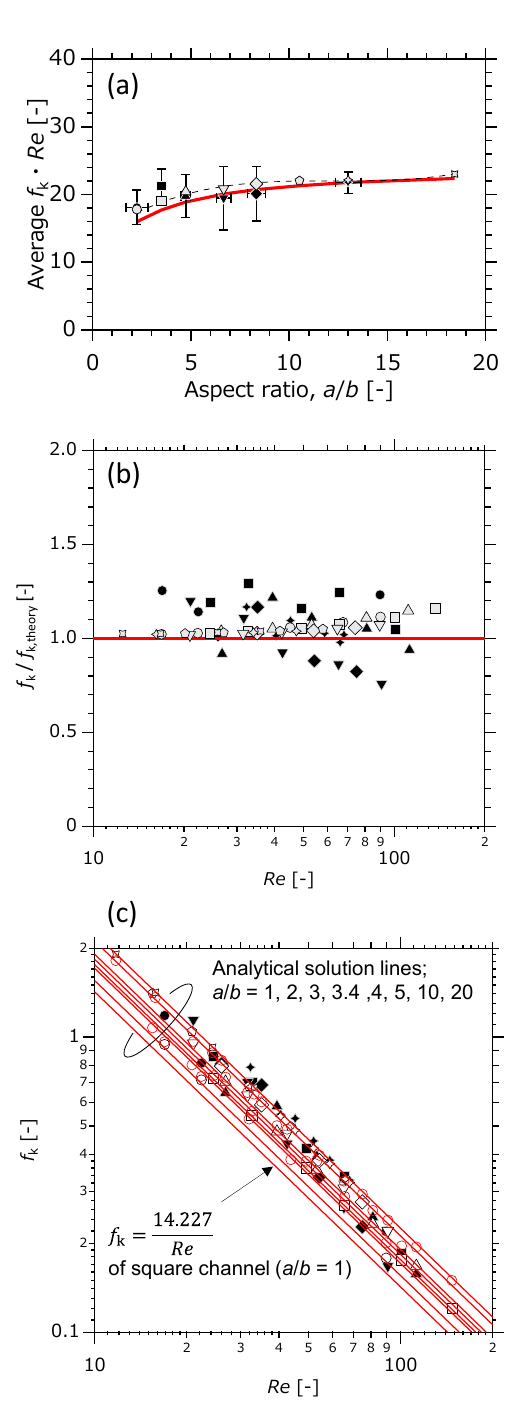
Figure 8. ( a ) relation between a and f k · Re , ( b ) tendency of f k and its error against Re ; Re vs. f k / f k,theory , ( c ) Re vs. f k . Filled black: experiment, filled gray: CFD (3D cal.), blank mark or solid line: analytical solution (1D cal.). The notation of the keys follows Figure 6.